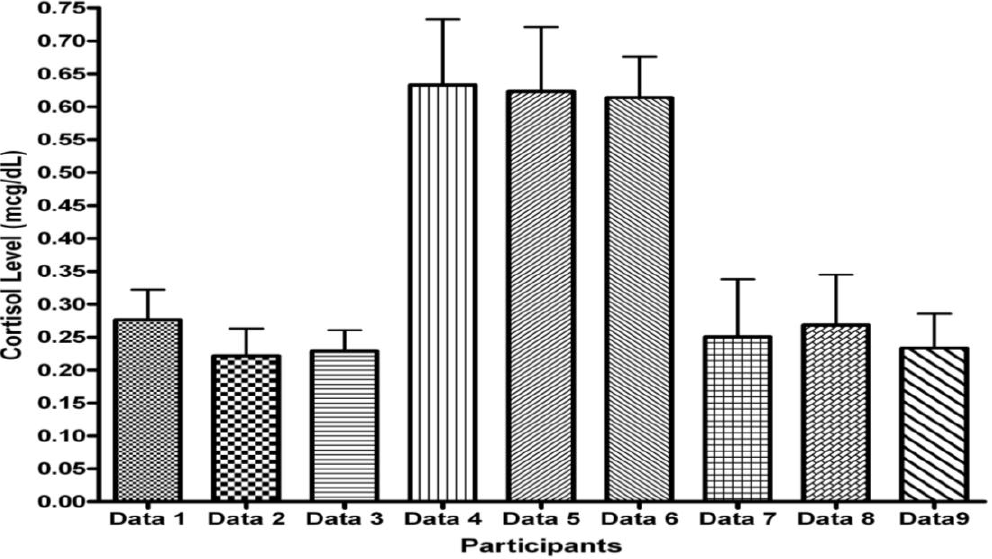
FIGURE 2. Average daily cortisol levels in three phases of data